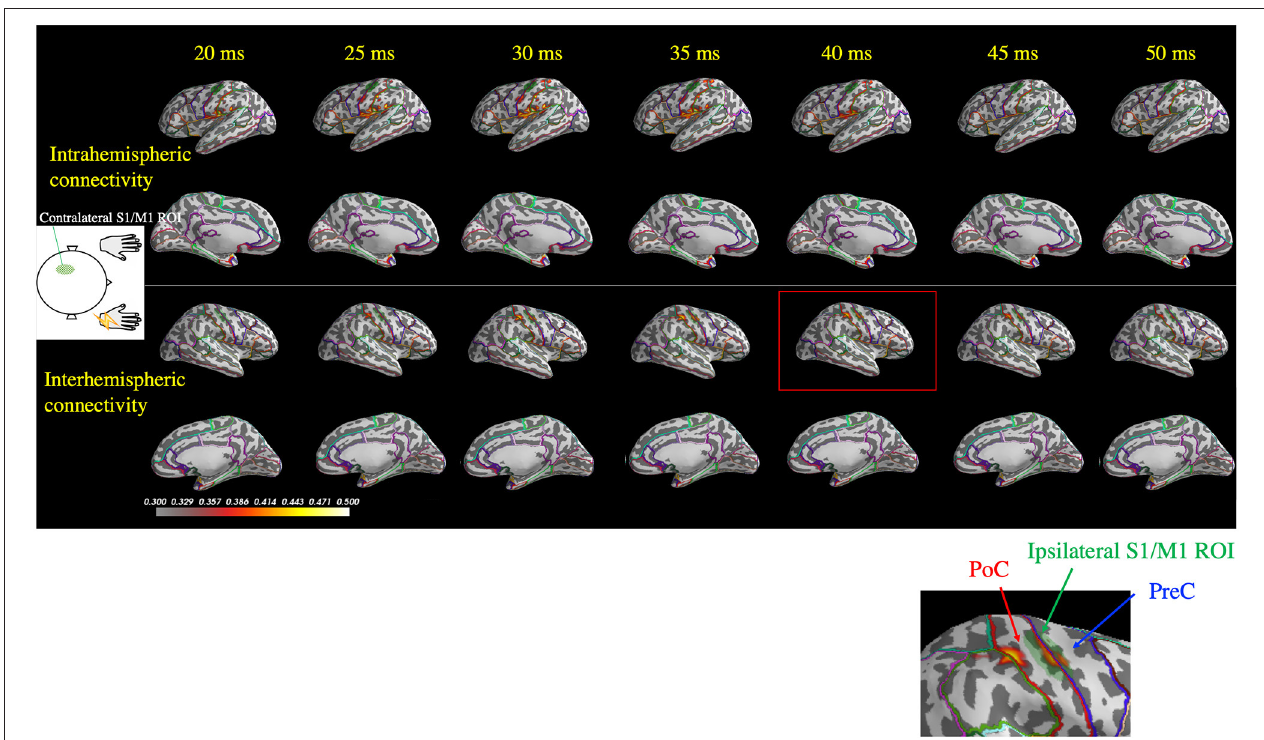
FIGURE 5 | Spatiotemporal distribution of the weighted phase-lag index (wPLI) between the contralateral S1/M1 region of interest (ROI; green shaded area in the left hemisphere) and the rest of the cortex following right median nerve stimulation (Patient 2). The wPLI was averaged over the 30–100Hz frequency window, which was identified using the intertrial phase coherence (see Figure 4A ). Top two panels: interhemispheric connectivity; bottom two panels: intrahemispheric connectivity. Interhemispheric connectivity was distinct in the time range of 30–50ms, especially in the S1/M1 ROI, whereas intrahemispheric connectivity showed a different pattern in the temporoparietal region. The inset shows a magnified view of the ipsilateral S1/M1 region at 40ms, which corresponds to the red rectangle. PoC, postcentral gyrus; PreC, precentral